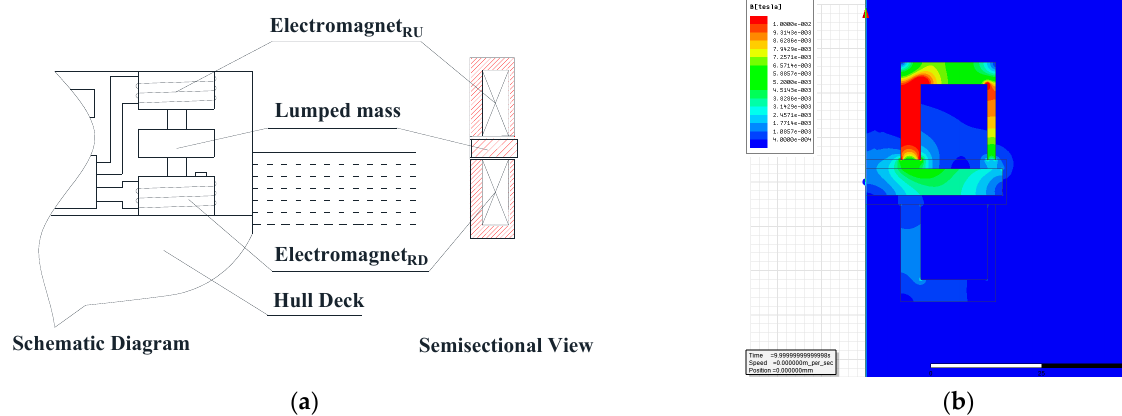
Figure 4. When the frequency is 10 Hz, the magnetic field distribution nephogram at 1 s. ( a ) Schematic diagram and semisectional view; ( b ) finite element diagram.